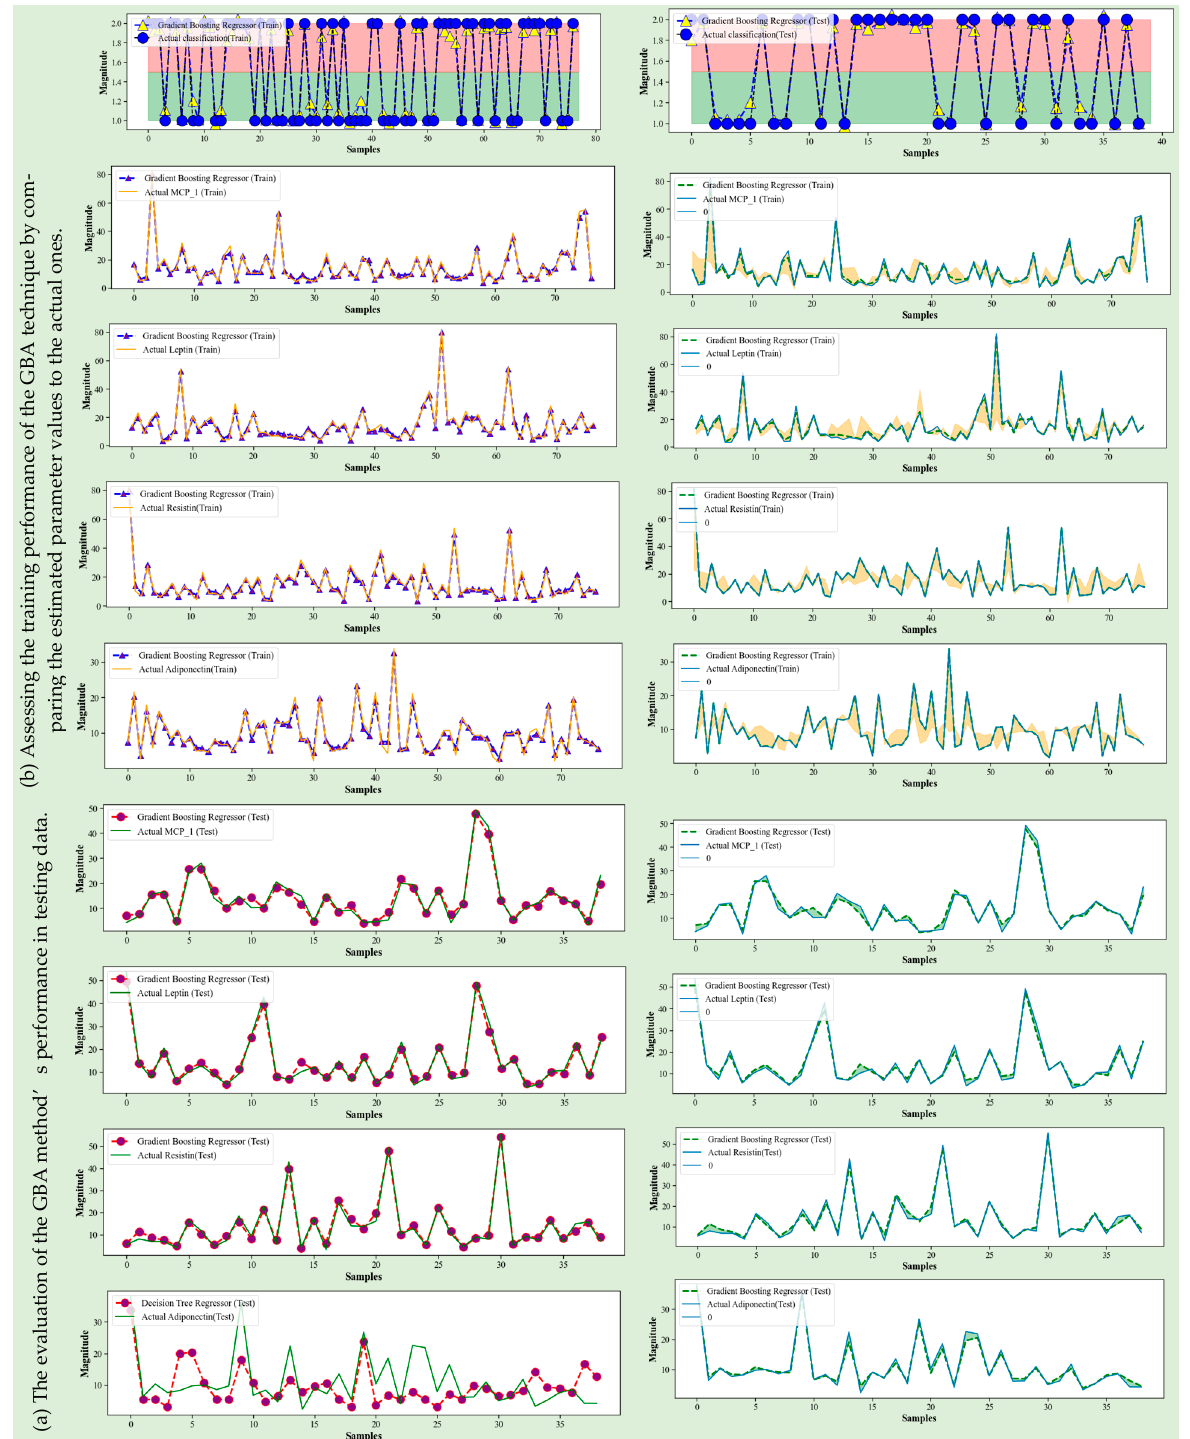
Figure 11. The GBA method’s capacity to identify breast cancer is exhibited by using it on both training and testing data. This means that the accuracy of the method is demonstrated by applying it to the training data, while the testing data are used to assess the